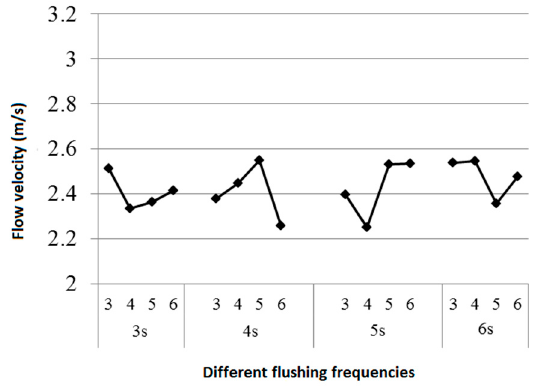
Figure 5. Comparison of water flow velocity at all frequencies (round nozzle in the middle of the pipe).